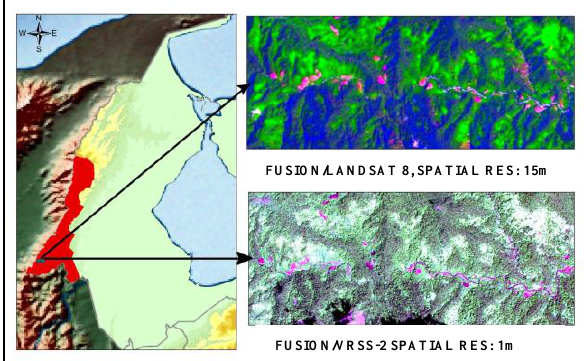
Figure 6. Selected area for the Gobia analysis.